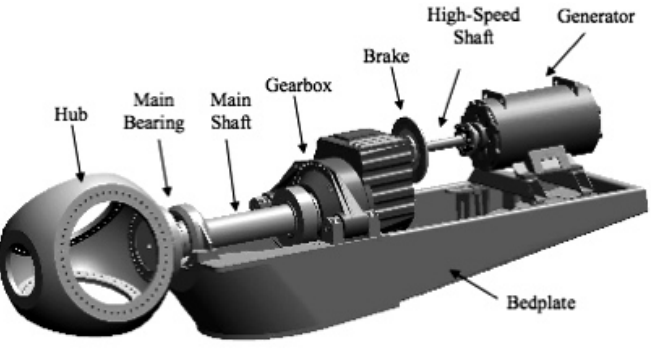
Figure 1. Modular configuration of wind turbine drivetrain components